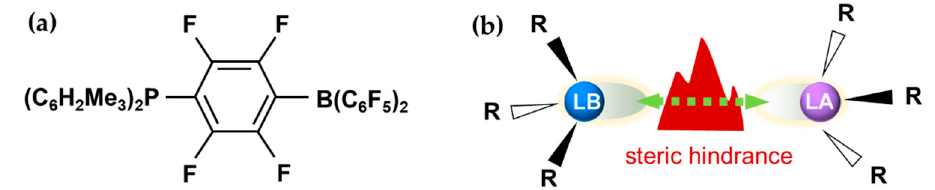
Figure 1. ( a ) Structure of the first reported homogeneous FLP. ( b ) Scheme of the common strategy for constructing homogeneous FLP catalysts. ( a ) is reproduced from reference [24] with permission.